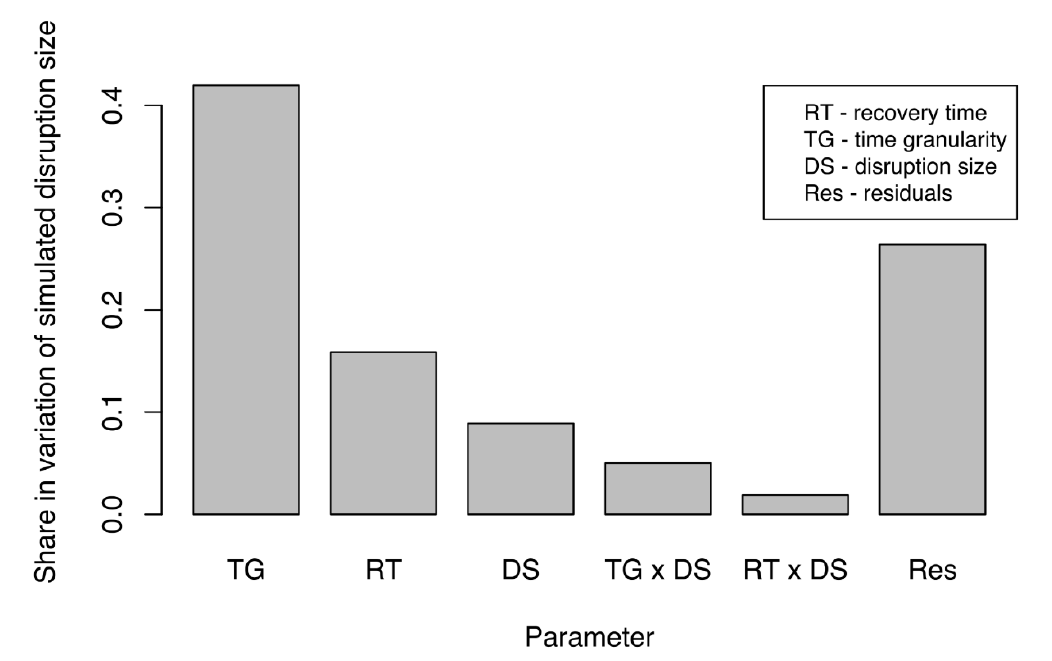
Figure 6. Share in overall variation for simulated disruption size (SPDS) due to experimental factors (param- eters).